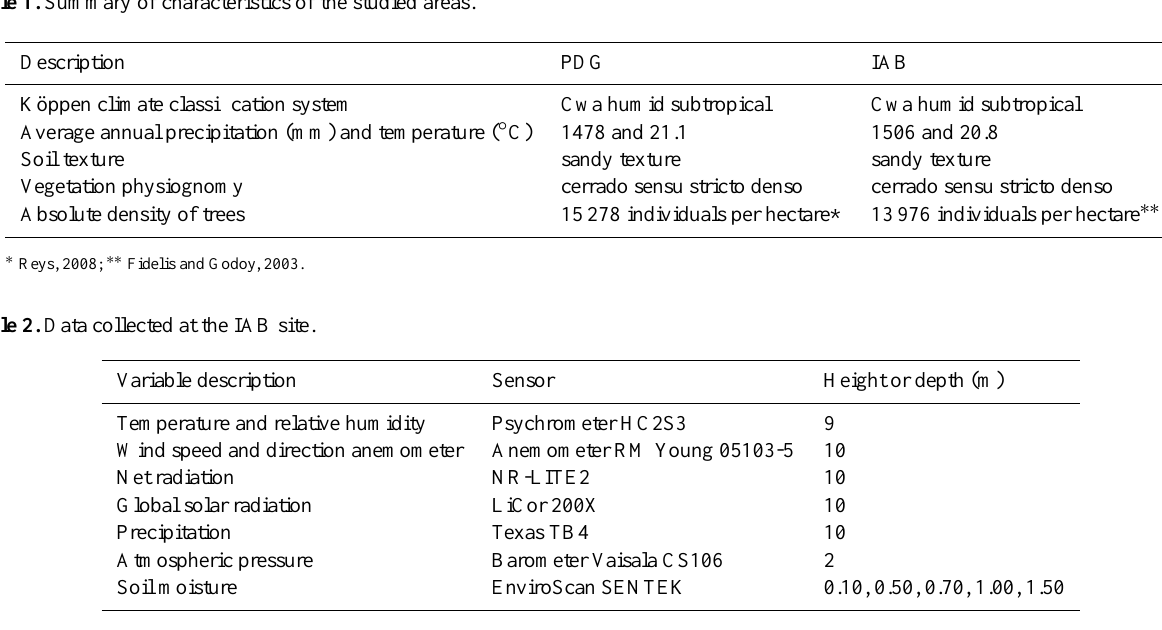
Table 1. Summary of characteristics of the studied areas.